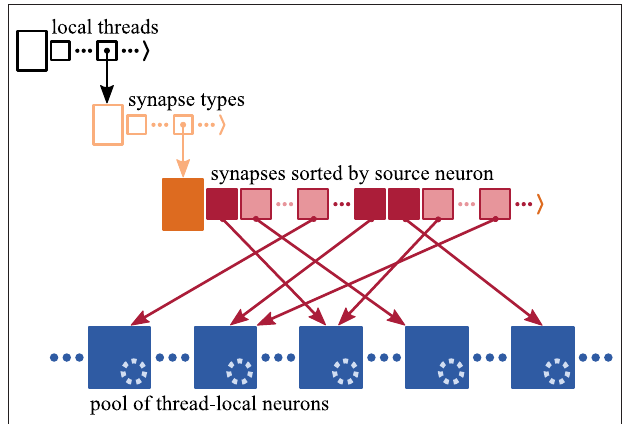
FIGURE 2 | Memory layout of synapse and neuron representations on each MPI process. Each process stores the local synapses (pink filled squares) in a three-dimensional resizable array sorted by hosting thread and synapse type. At the innermost level, synapses are arranged in source-specific target segments (dark pink: first synapse; light pink: subsequent targets); only one innermost array is shown for simplicity. Target neurons (blue filled squares) are stored in neuron-type and thread-specific memory pools; only one pool is shown for simplicity. Each neuron maintains a spike ring buffer (dotted light blue circles). Synapses have access to their target neurons through target identifiers (dark pink arrows).